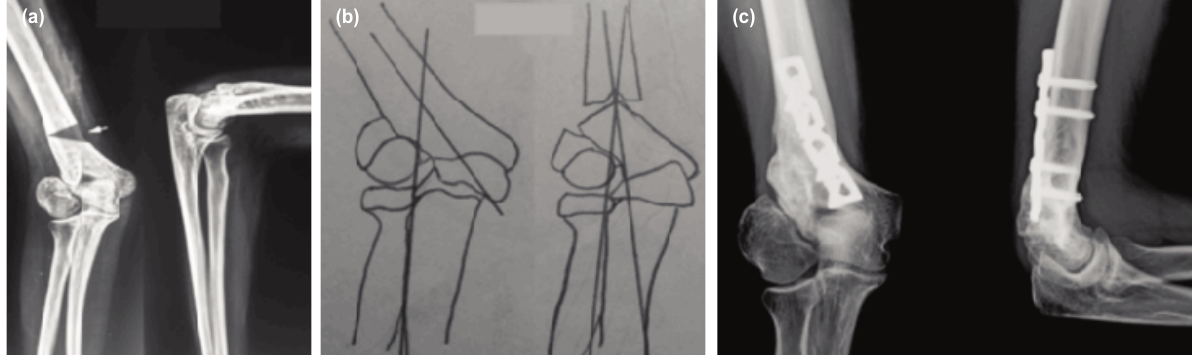
(a) A 18-year-old female patient presented with TUNP secondary to cubitus valgus deformity right side - Pre-operative Fig. 1: radiograph showing non-union of the lateral condyle humerus and cubitus valgus deformity (36° valgus). White arrow shows site of planned osteotomy. Black overlaid triangle shows site of planned osteotomy. (b) Milch osteotomy was done to correct the deformity and fixed with plate, without osteosynthesis of the non-union and anterior transposition of ulnar nerve. (c) Six months post-operative radiograph showing union at the osteotomy site and carrying angle corrected to 10° valgus. Excellent results were seen for deformity correction and ulnar nerve symptoms.